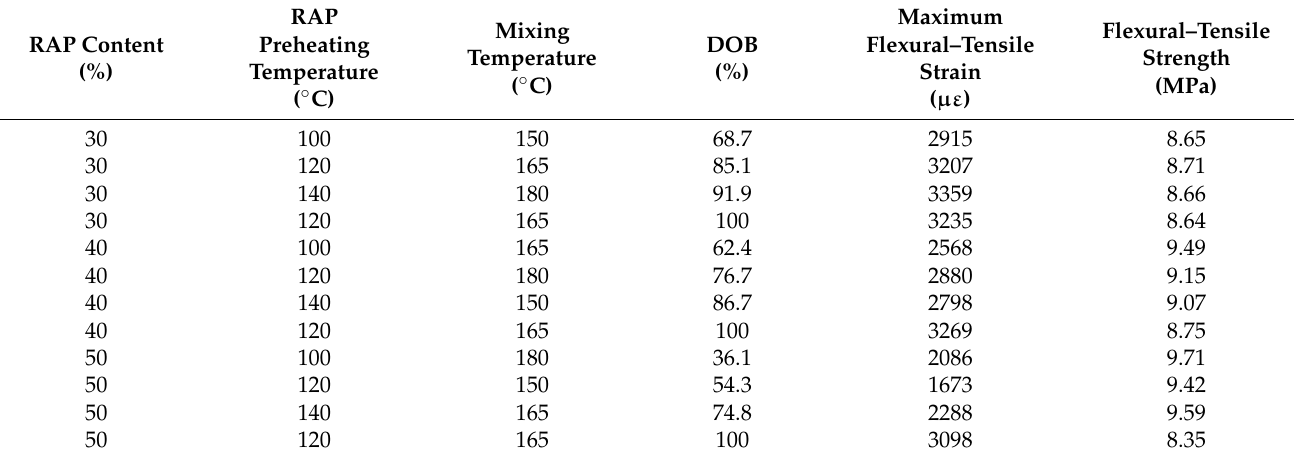
Table 7. Test results of the low-temperature beam bending test.